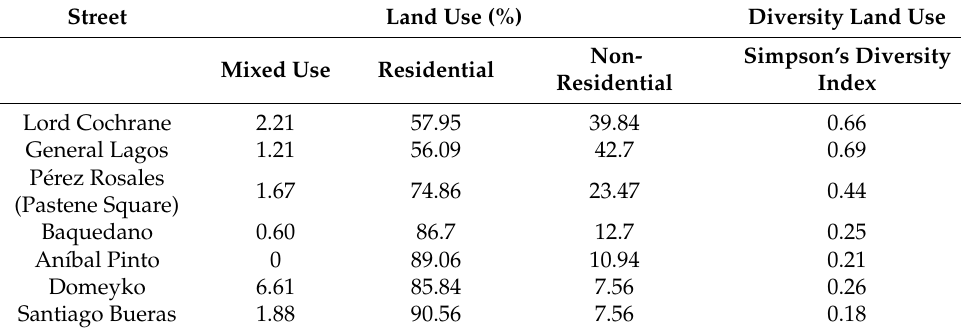
Figure 3. Land uses map of the Barrios Bajos, Valdivia. Source: Authors. Table 2. Land use percentages and streets with a high diversity of land uses according to Simpson’s diversity